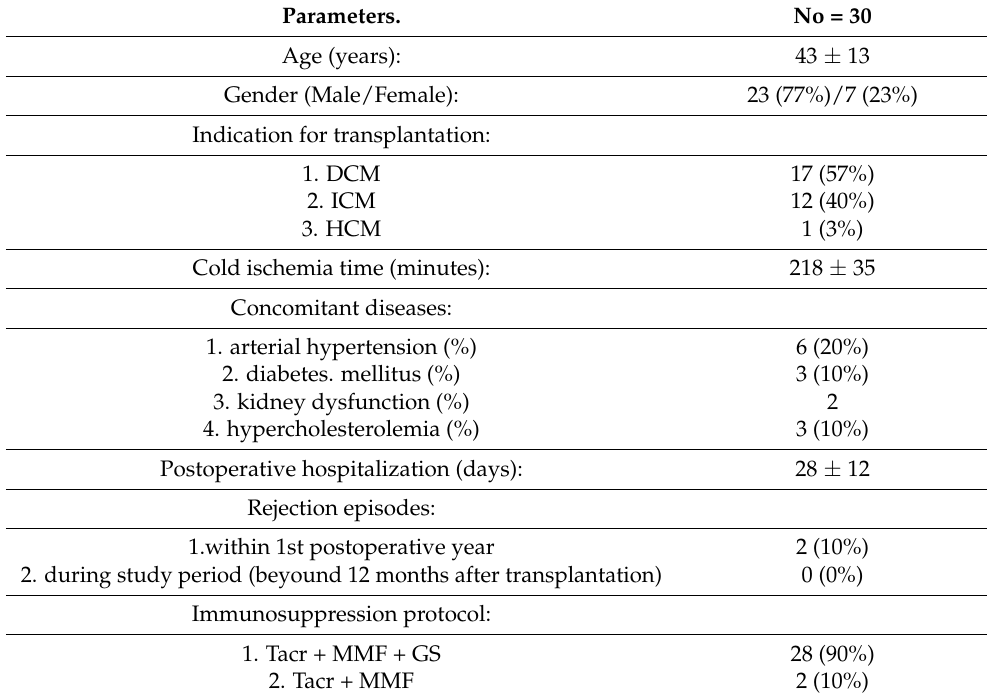
Table 1. Demographical and clinical data.